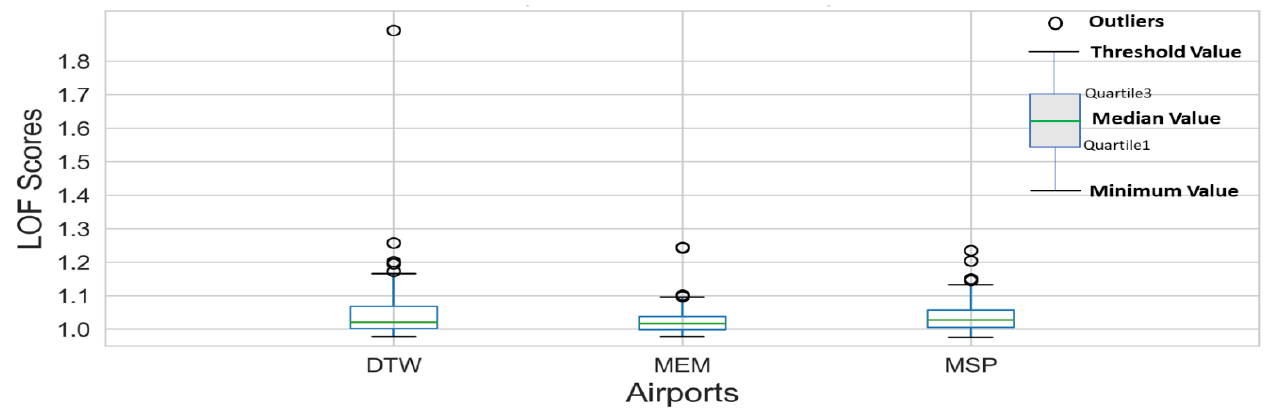
Figure 10. LOF analysis for three different airports.